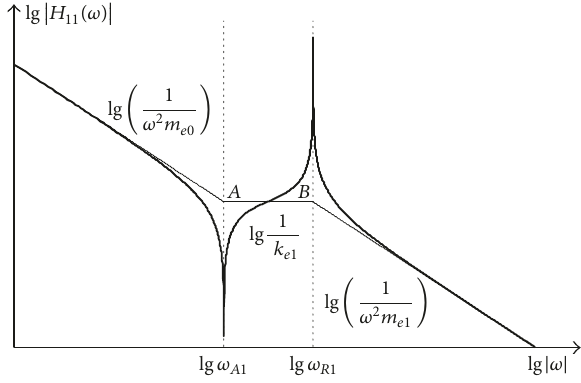
Figure 5: Log magnitude-frequency characteristic curve of